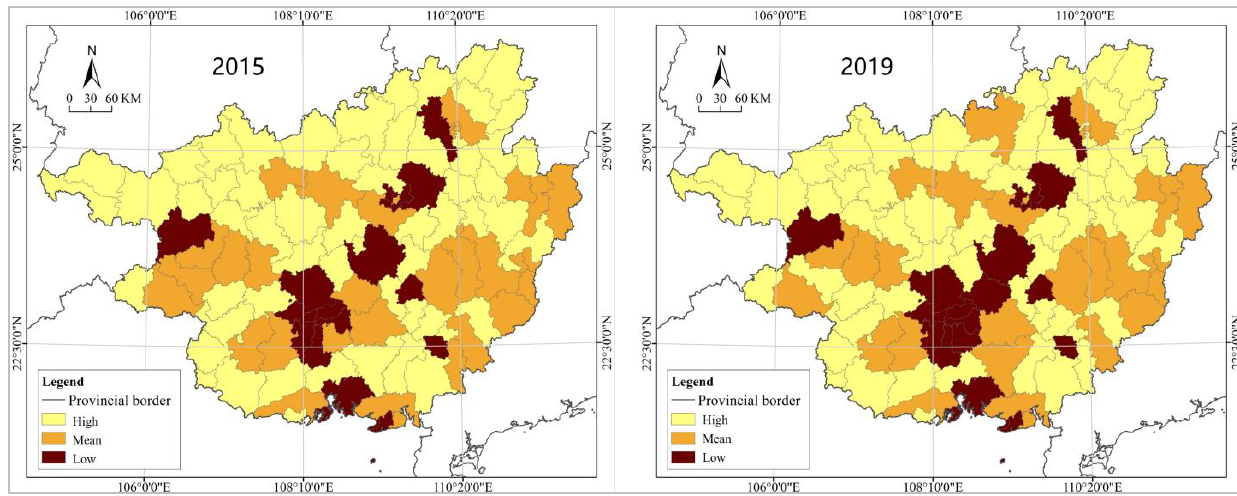
Figure 6. Spatial cluster analysis of night light extended vitality index in Guangxi. According to the spatial correlation analysis based on GeoDA, the Global Moran’s I of Guangxi urban night light extended vitality index in 2015 and 2019 was 0.26 and 0.27 (confidence level is 0.001), respectively, with little changes, indicating that the urbaniza- tion development quality in Guangxi has a long-term positive spatial autocorrelation and the spatial correlation is stable. At the significance level of 0.1, the results of local autocor- relation analysis are similar to those of urban night light index. In 2015, H-H cities were mainly concentrated in the capital city circle of Nanning, the Beibu Gulf coastal city clus- ter, and the city cluster in central Guangxi, while L-L cities were concentrated in the north- ern Guangxi border and northeast Guangxi. There were a small number of L-H and H-L